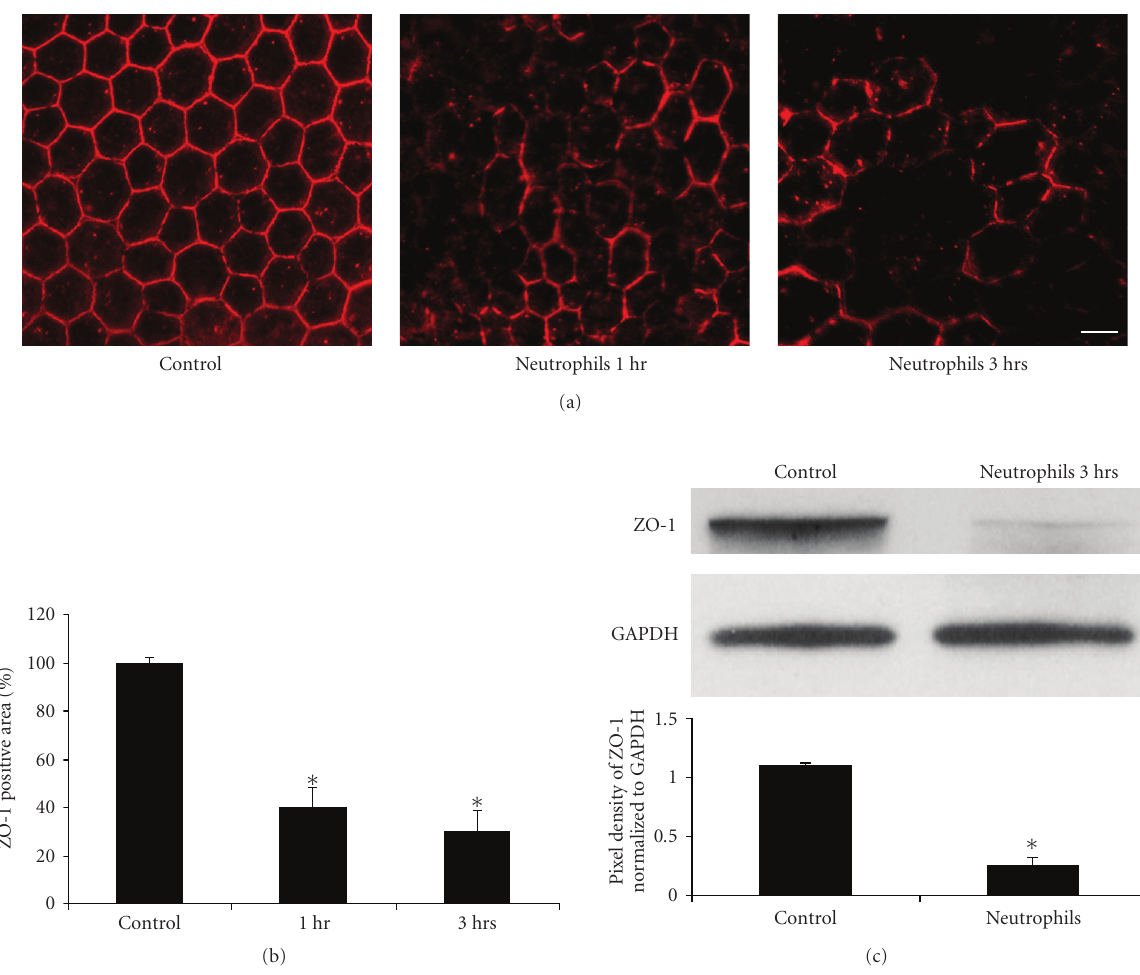
Figure 2: Neutrophils induced disruption of the tight junction protein ZO-1 in the RPE monolayer. (a) ZO-1 immunofluorescence staining on RPE-Choroidal explants. (b) Quantative analysis of ZO-1 immunofluorecence area on RPE–Choroidal explants. Bovine RPE-Choroidal explants were incubated with neutrophils for 1 to 3 hours at 37 ◦ C. ZO-1 expression was determined by confocal immunomicroscopy using anti-ZO-1 Ab. Quantitation of ZO-1 staining positive area was analyzed by using LSM 510 image software. ∗ represents P < . 01. Bar = 50 μ m. (c) Western blot analysis of ZO-1 expression after RPE choroidal explants exposed to neutrophils for 3 hours. In Figure 2(c), the result of densitometry from the western blot (upper panel), normalized to GAPDH, shows significant loss of ZO-1 protein, P < .